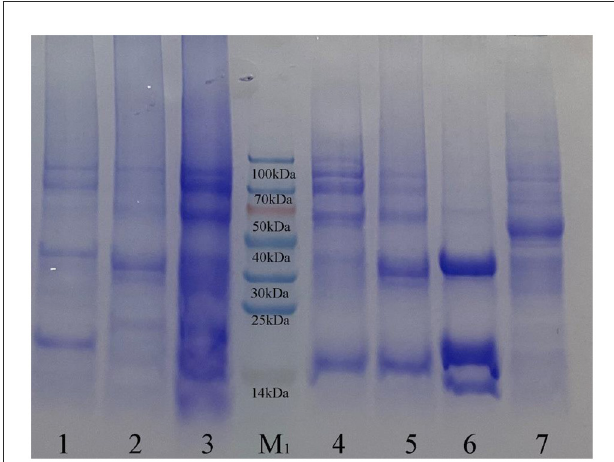
FIGURE2 Sodium dodecyl sulfate polyacrylamide gel electrophoresis results. Lane1, Purified sample of target protein from strain E. coli PC; Lane2, Purified sample of target protein from strain E. coli APC; Lane3, Purified sample of target protein from strain E. coli PC-APC; Lane4, Purified sample of target protein from strain E. coli PC-APC-HPUSTEF Protein purification sample; Lane5, Purified sample of target protein from strain E. coli PC-HPUSTEF; Lane6, Purified sample of target protein from strain E. coli APC-HPUSTEF; Lane7, Unpurified protein sample of control E. coli BL21; Lane M 1 , SDS-PAGE Protein Marker.